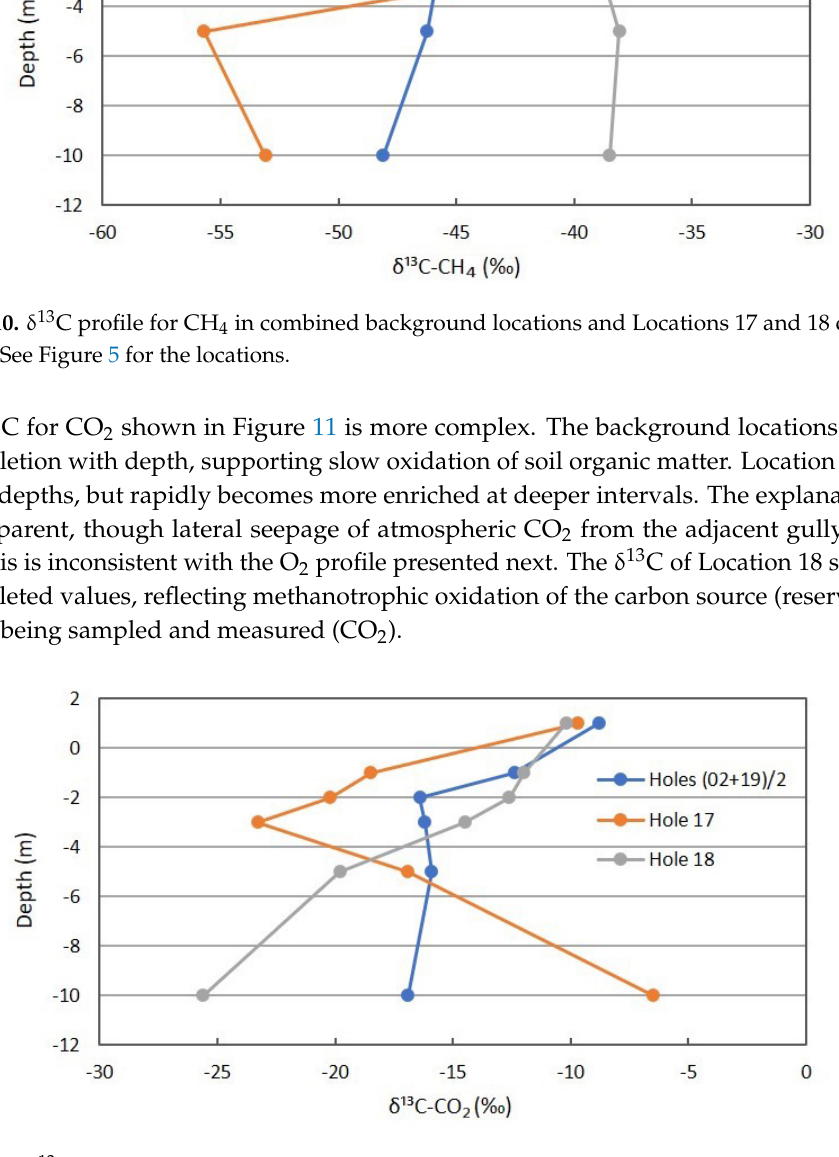
Figure 11. δ 13 C profile for CO 2 in combined background locations and Locations 17 and 18 in Fault Zone 2. See Figure 5 for the